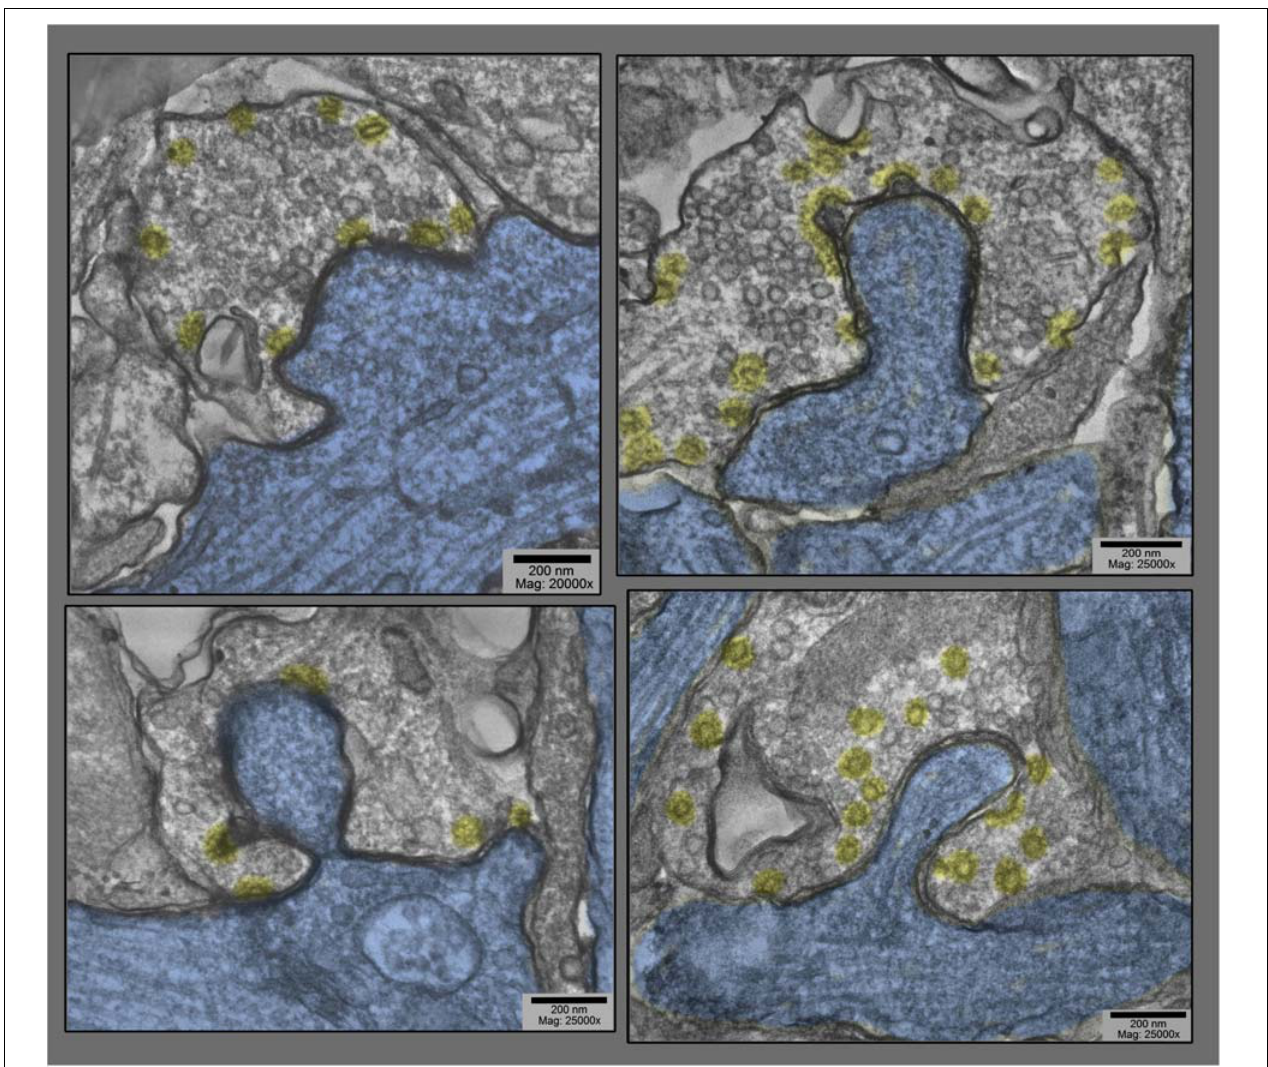
FIGURE 2 | Examples of dendritic shaft synapses in hippocampal cultures exposed to 0.1 mM La + + + for 10–20 min at 37 ◦ C. Synaptic vesicles are more or less depleted, but in all cases, clathrin-coated vesicles (presumably involved in the recycling of synaptic vesicle membrane) are increased in abundance, especially along the borders of the postsynaptic “protrusions” (highlighted in blue). Being shaft synapses (thus presumably inhibitory or Gray’s type II), the PSDs are not prominent in these fields and thus are not highlighted in